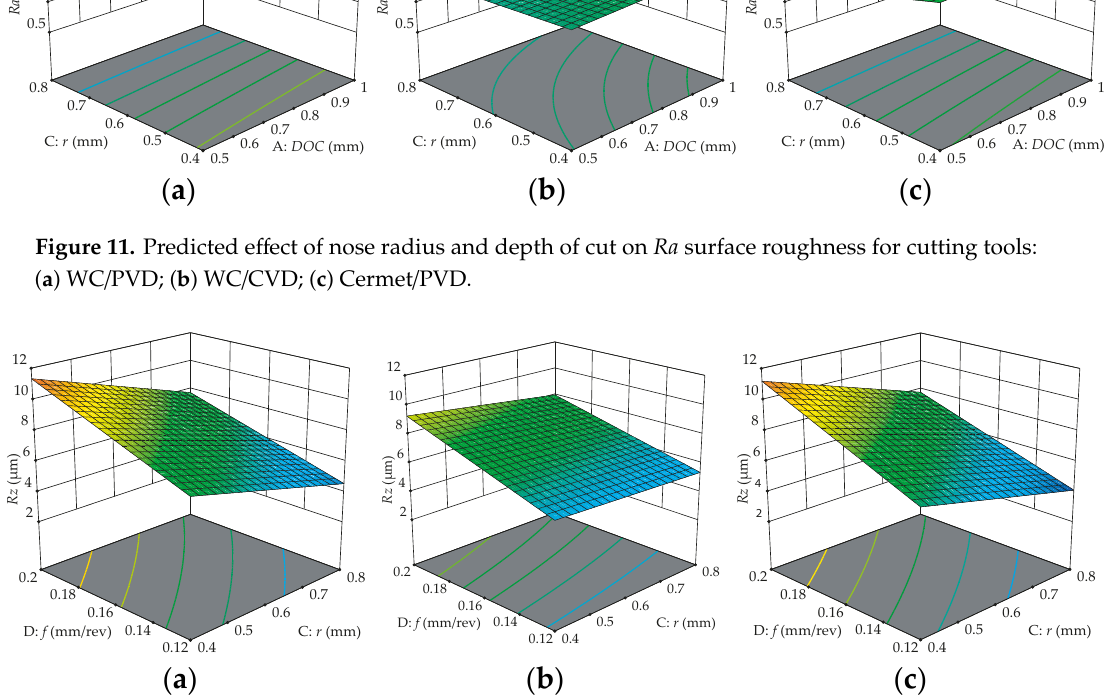
Figure 12. Predicted effect of feed rate and nose radius on Rz surface roughness for cutting tools: ( a ) WC/PVD; ( b ) WC/CVD; ( c ) Cermet/PVD.